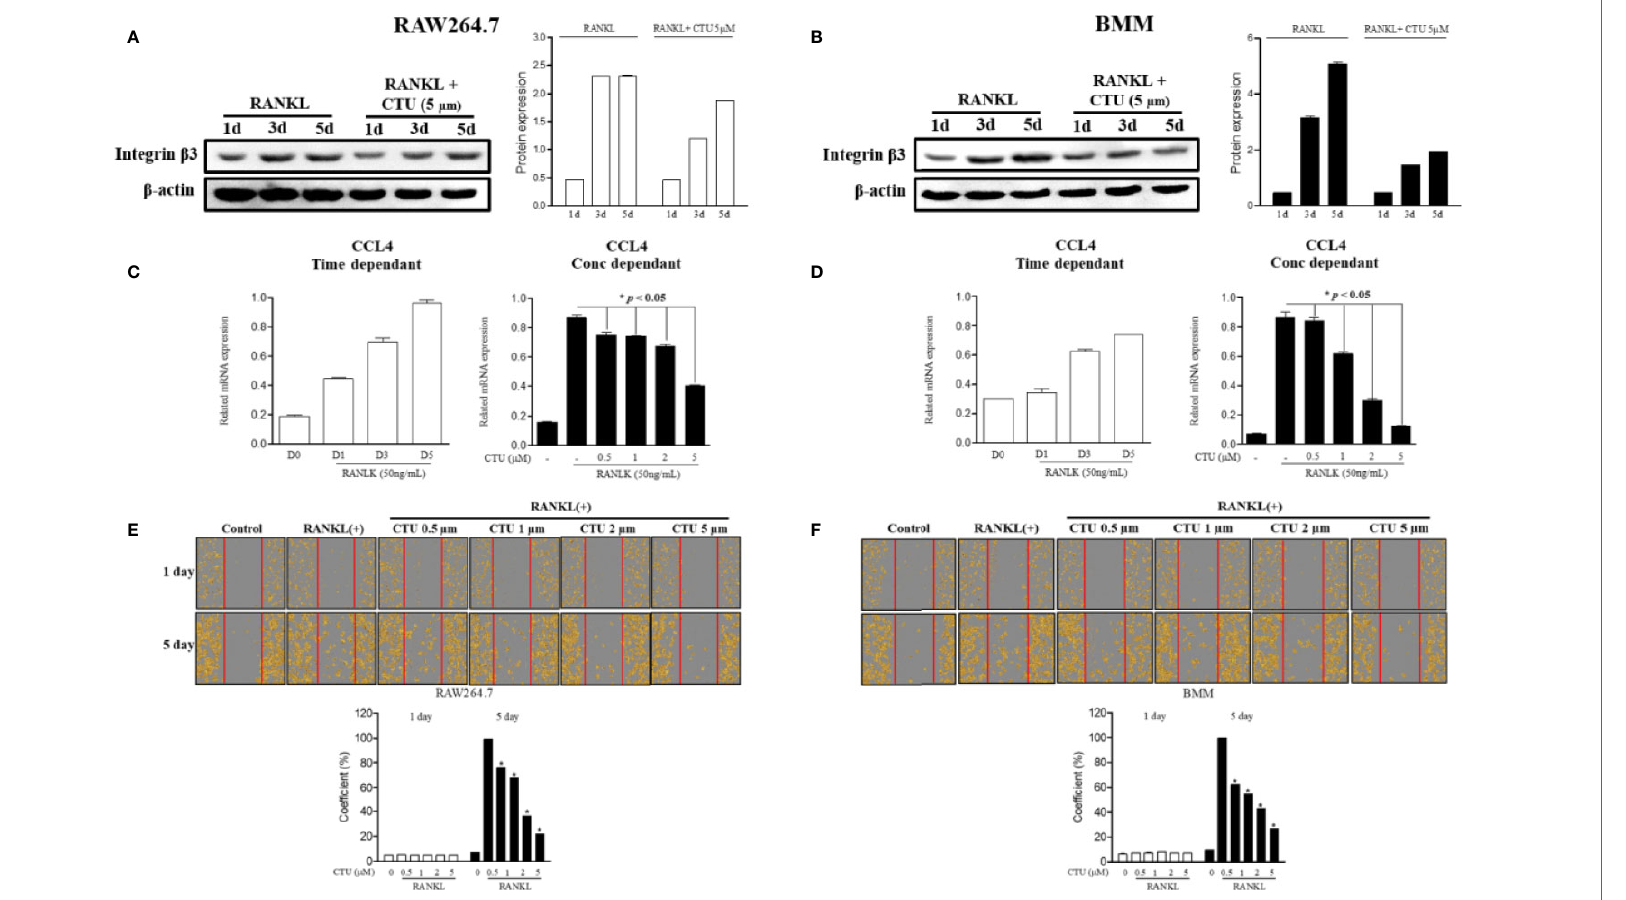
FIGURE 5 | The effect of CTU on RANKL-induced osteoclast migration. RAW 264.7 and BMM cells were cultured in the presence of CTU and RANKL for 1 – 5 days to induce osteoclast differentiation, and the protein expression of integrin b 3 was measured by Western blot (A, B) , and the levels of CCL4 mRNA were measured by real-time PCR (C, D) . RAW264.7 and BMM cells were cultured without or with RANKL for 3 d, and further incubated for 24 h in the presence of CTU (0.5, 1, 2, and 5 m M) after gentle scratching (E, F) . The number of migrated cells was averaged using IncuCyte-image marking software. *p < 0.05 compared with the only RANKL-treated